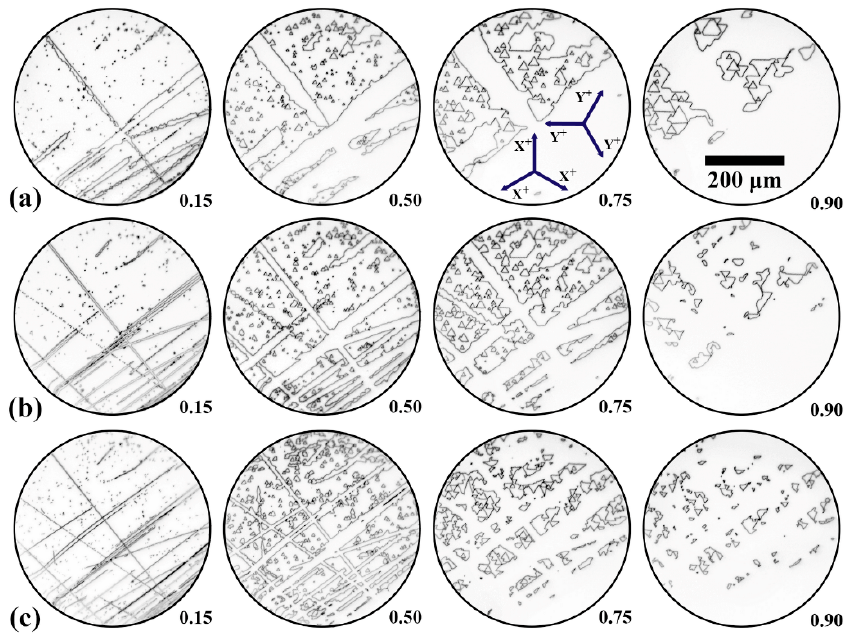
Figure 2. The domain wall images during the application of the pulse series with field amplitudes E ex , kV/mm: ( a ) 5, ( b ) 7.5, and ( c ) 12.5. The fraction of the switched area for each image is indicated.